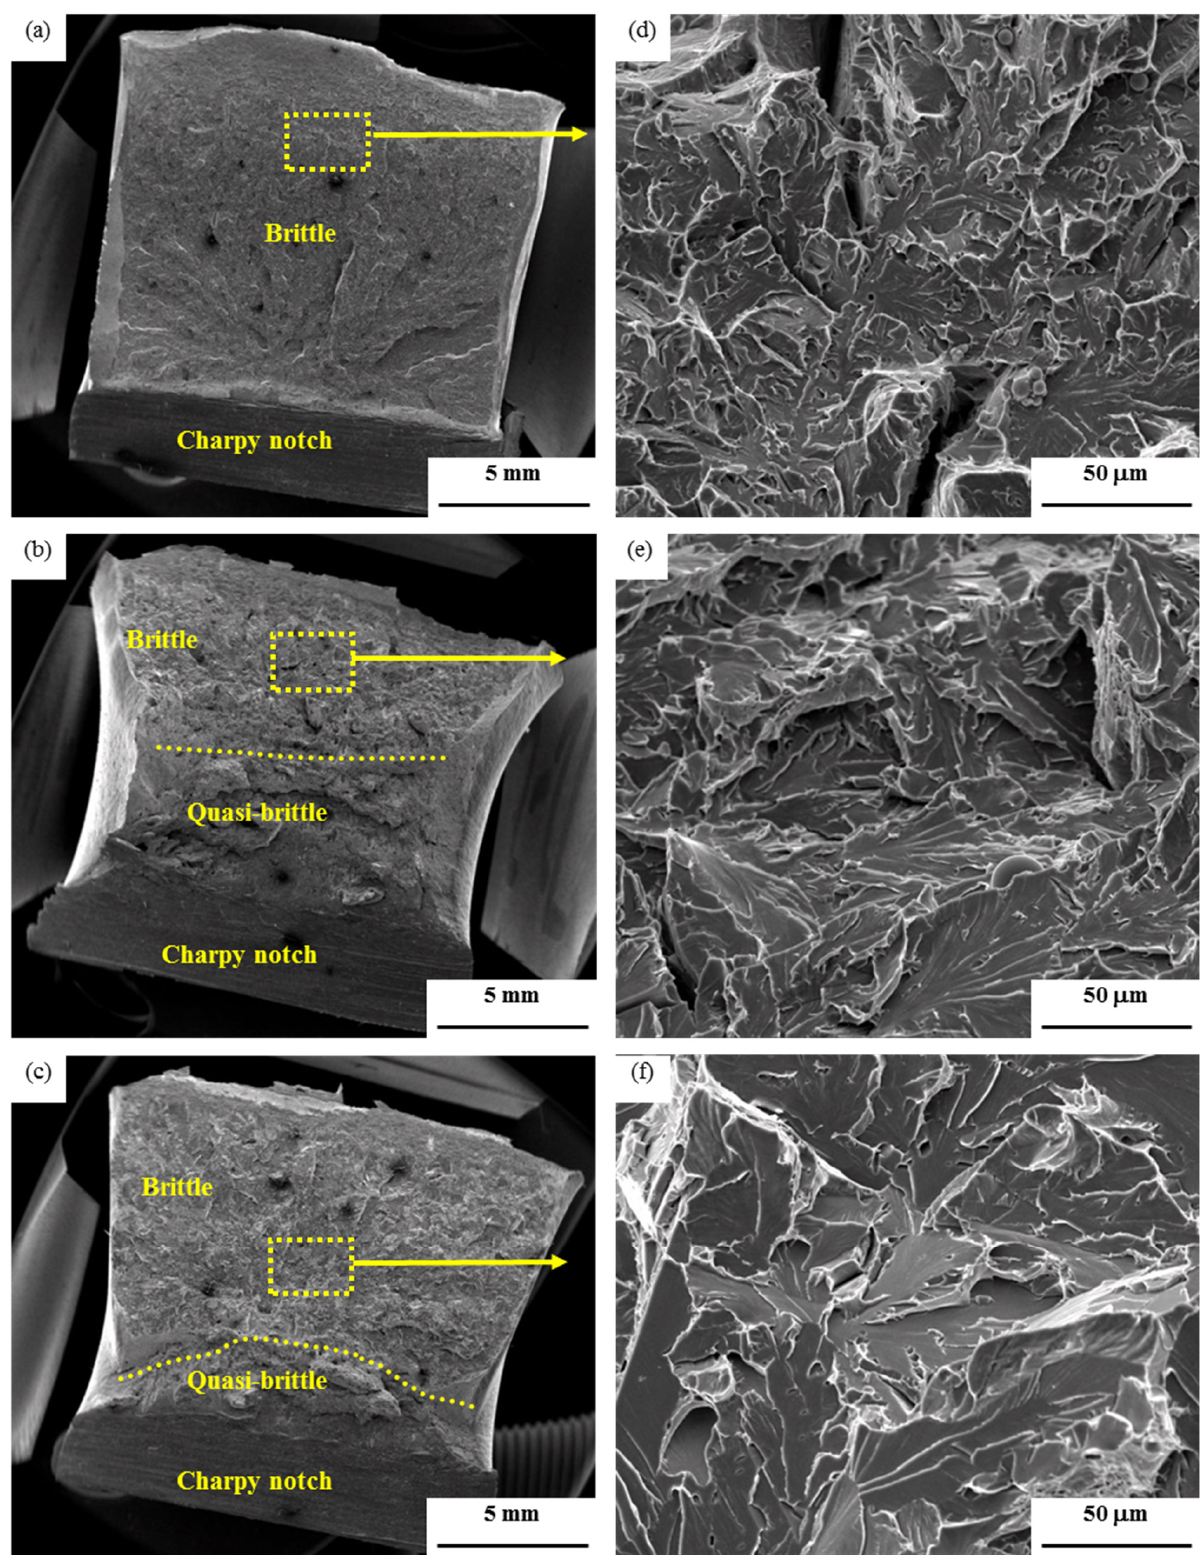
Figure 7. SEM fractographs of specimens Charpy impact tested at − 20 °C of the base metal ( a ) and ( d ), CGHAZ with 100 kJ/cm ( b ) and ( e ), CGHAZ with 400 kJ/cm ( c ) and ( f ) of the water-quenched initial microstructure.